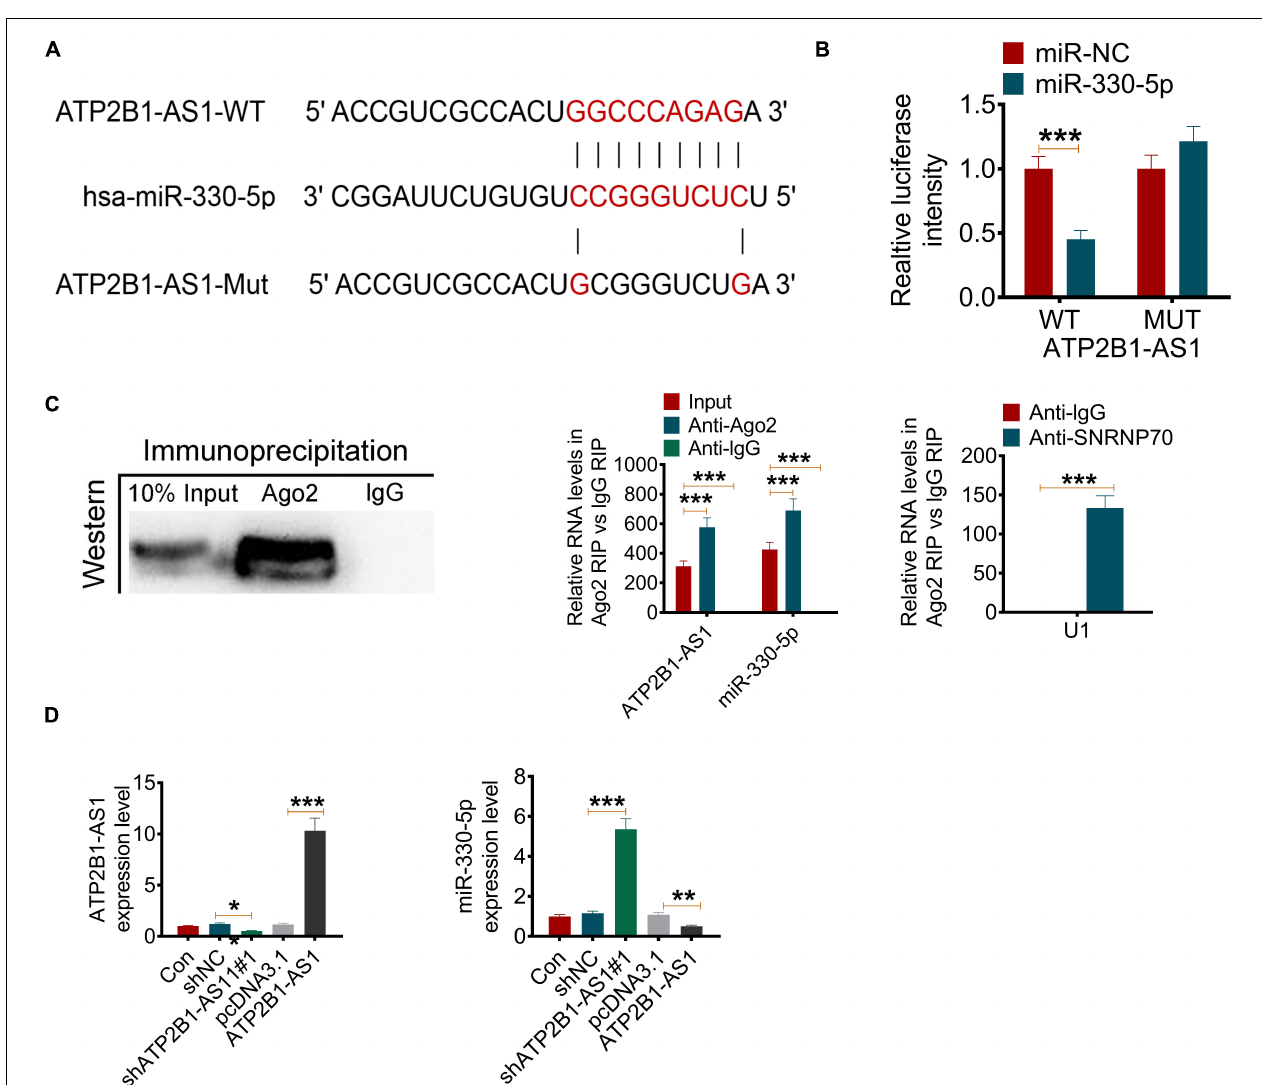
FIGURE 4 | ATP2B1-AS1 targets miR-330-5p. (A) The possible interact target of ATP2B1-AS1 was predicted by StarBase. ATP2B1-AS1 could bind miR-330-5p at 3’-UTR. (B,C) The binding of ATP2B1-AS1 and miR-330-5p was validated by the dual-luciferase reporter assay (B) and RIP assay (C) . (D) Effect of sh-ATP2B1-AS1 and ATP2B1-AS1 overexpression on the expressions of ATP2B1-AS1 and miR-330-5p. * P < 0.05, ** P < 0.01, *** P <